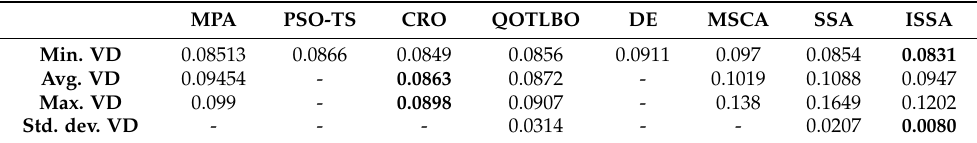
Table 12. Statistical comparison of results for voltage deviation minimization for IEEE 30-bus system.